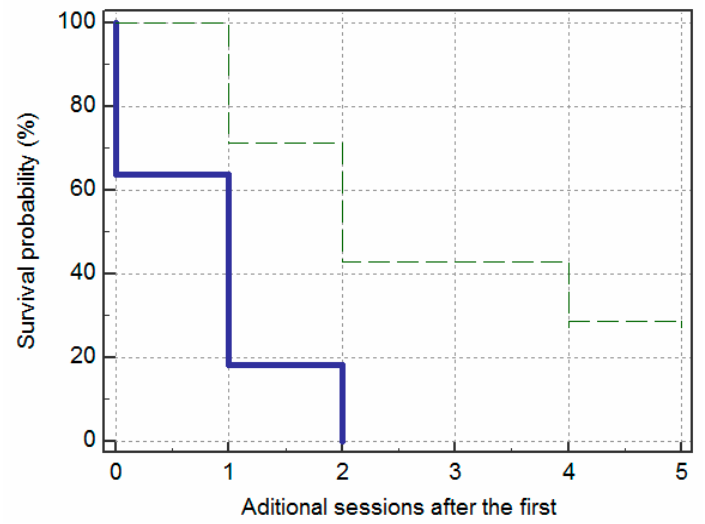
Figure 5. Kaplan–Meier survival curves demonstrating remissions over the number of additional PNE sessions, according to fistula appearance: elongated (solid line) and ovoid (dashed line).